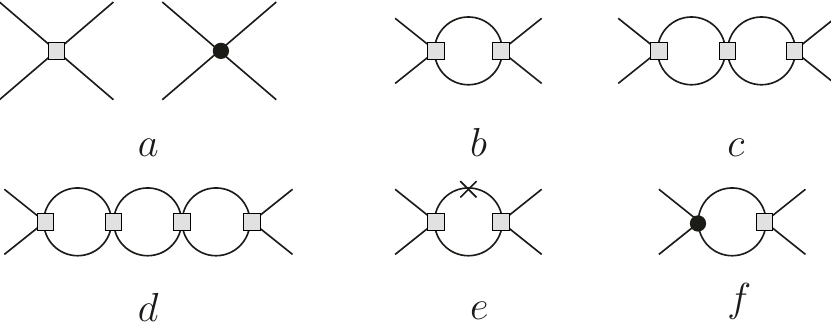
, p 0 ; p 1 , p 2 ) up 1 2